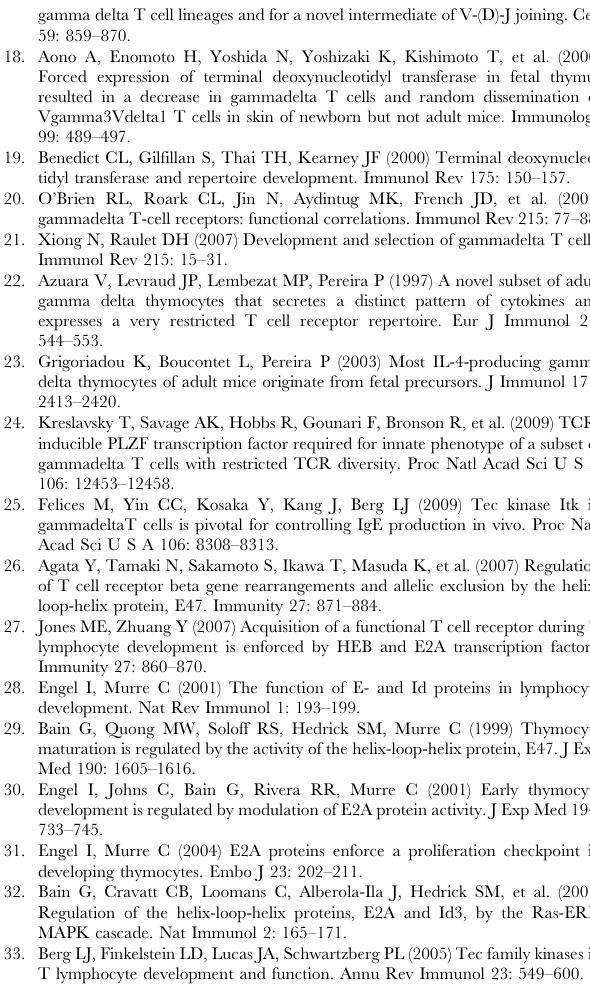
Figure S7 Deletion of Sh2d1a restores thymus cellularity and reverses the activated phenotype of cd cells in Id3 2 / 2 mice. (A) Total thymocytes numbers in mice of the indicated genotypes. At